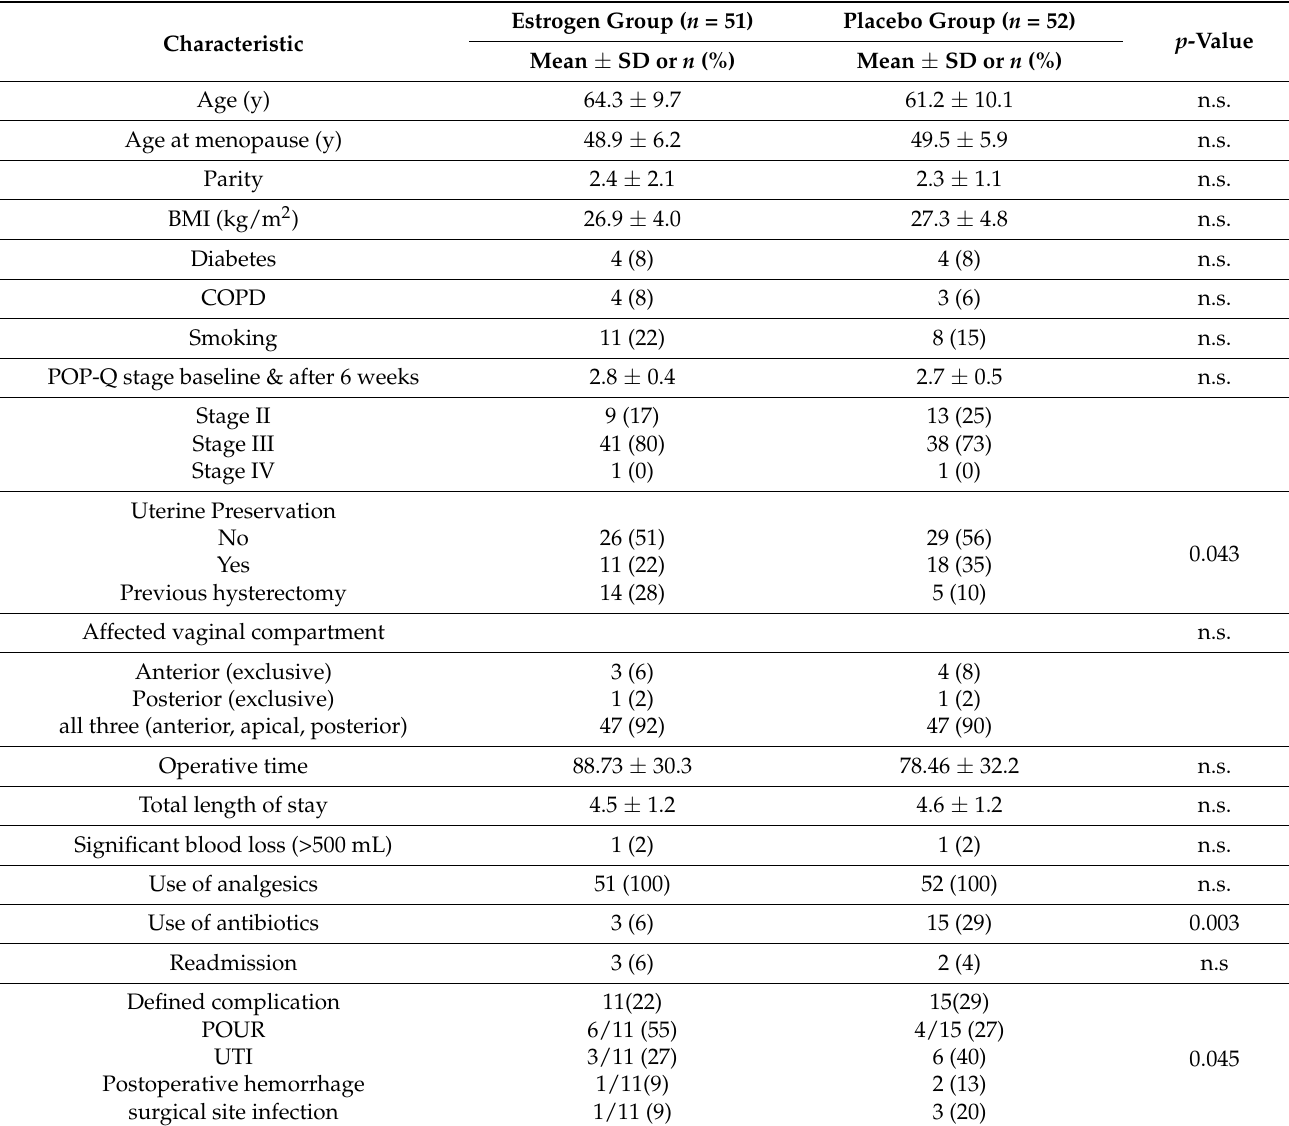
Table 1. Baseline characteristics of the study population ( n =